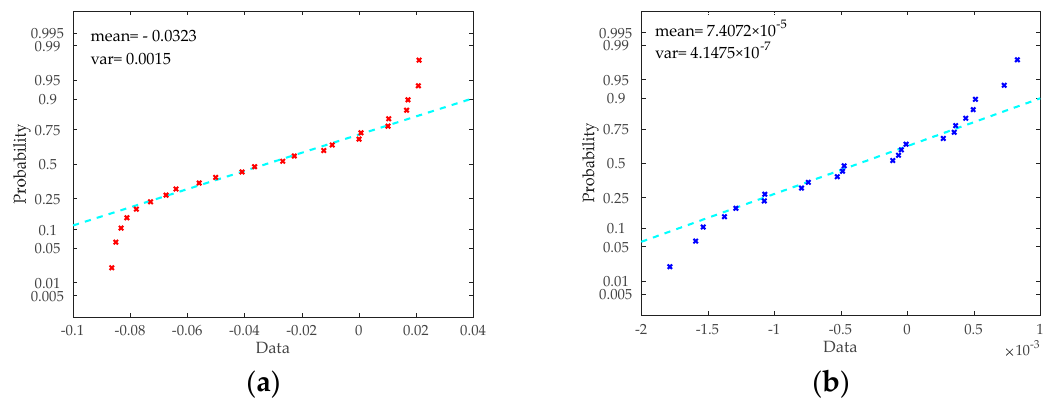
Figure 10. ( a ) Probability plot for normal distribution before compensation. ( b ) Probability plot for